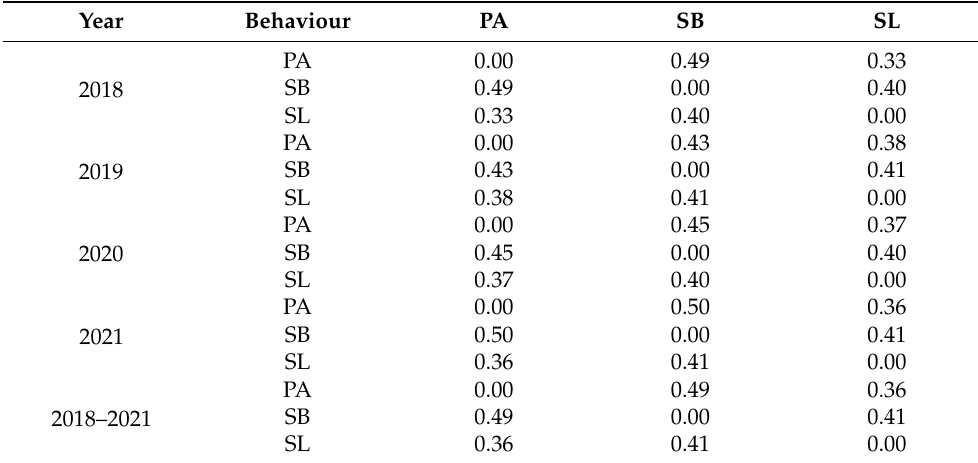
Table 2. Compositional variation matrix for PA, SB, and SL from